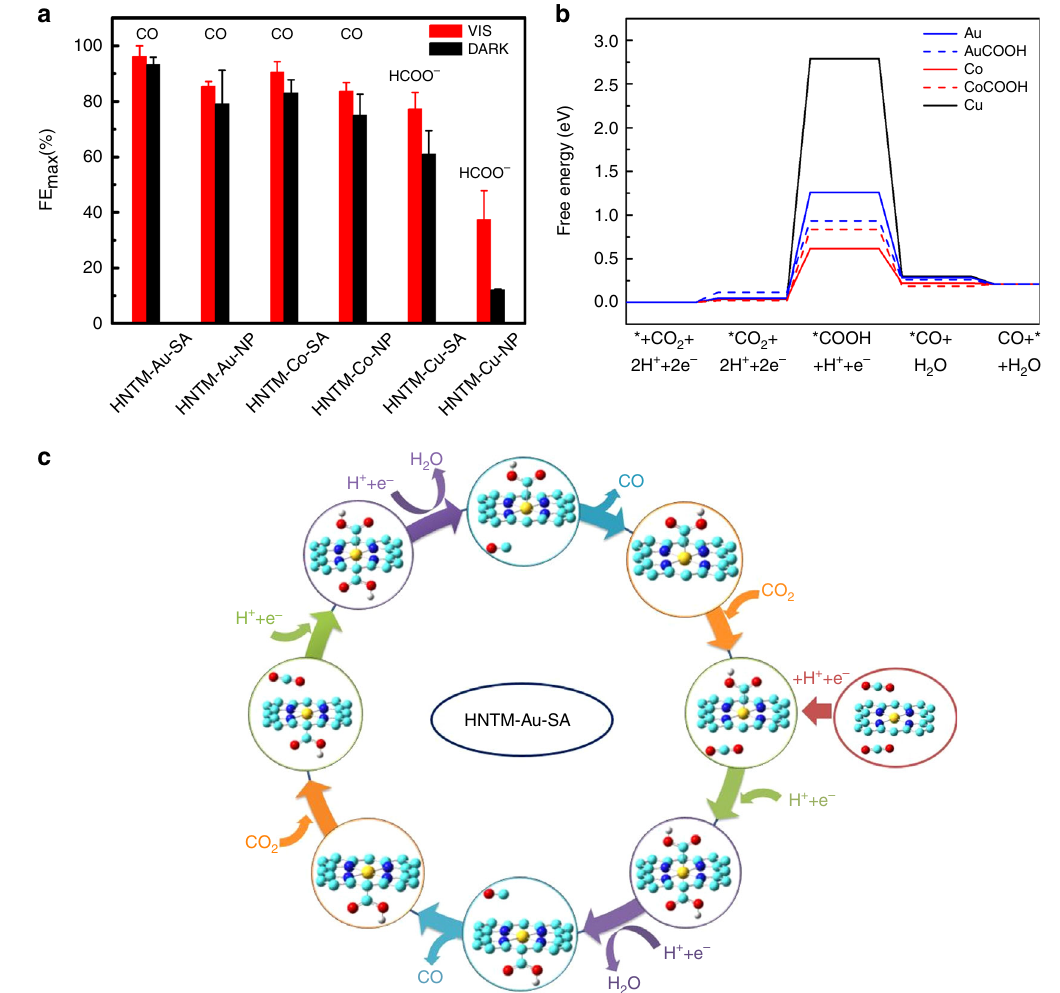
Fig. 5 Density functional theory calculations. a FE maximum and product observed on each catalyst. Red and black color bars represent FE under light/dark conditions, respectively. Error bars are ± s.d. b Calculated free energy pro fi le of electrochemical reduction of CO 2 to CO. c The synergistic catalysis mechanism of CO 2 reduction on